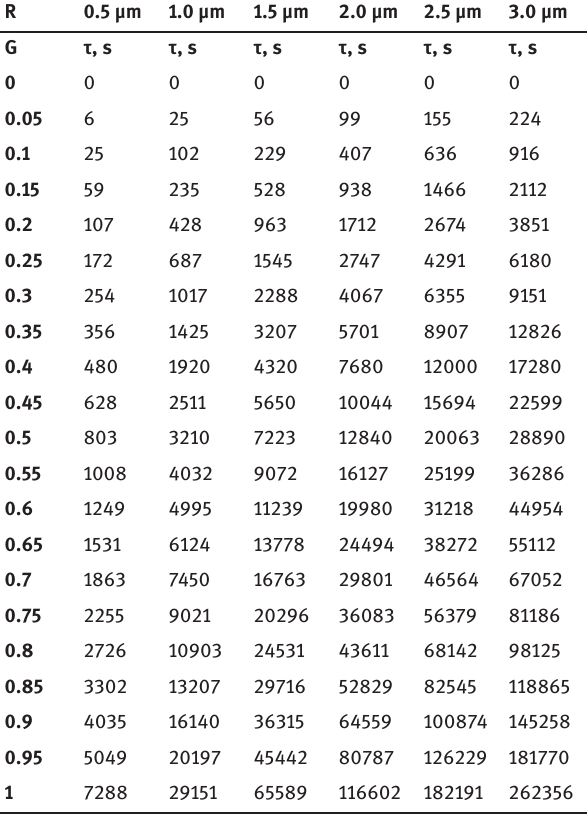
Table 3: Elapsed time in order to reach a specific value of conversion (K = 1.143·10 -17 m 2 /s).